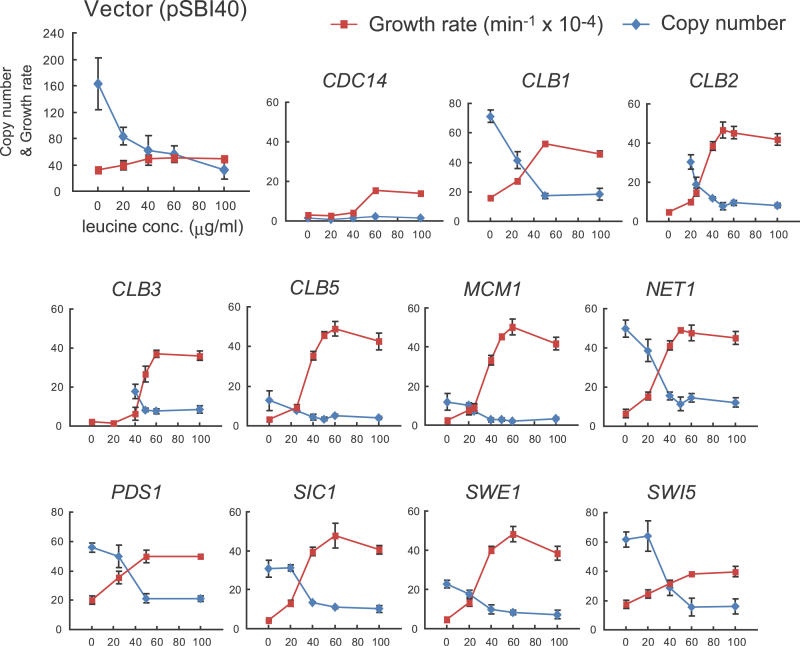
Determination of Upper Limit Gene Copy Number with Leucine SupplementationGrowth and copy number of plasmids in the gTOW experiment with various leucine concentrations are shown. The data used in the graphs are listed in Table S2.